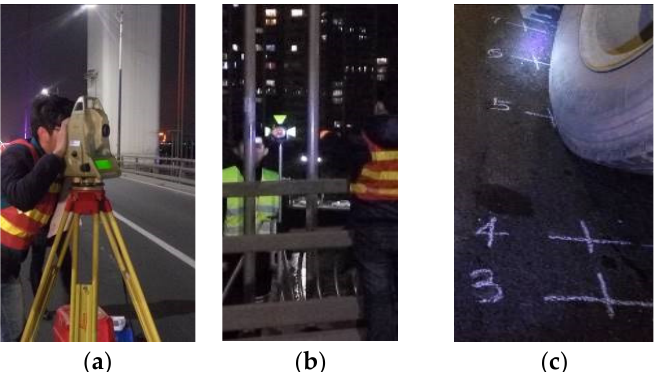
Figure 8. Methods to locate wheel loads: (a) Total station measurement points; (b) observation point positioning; (c) chalk record wheel position.